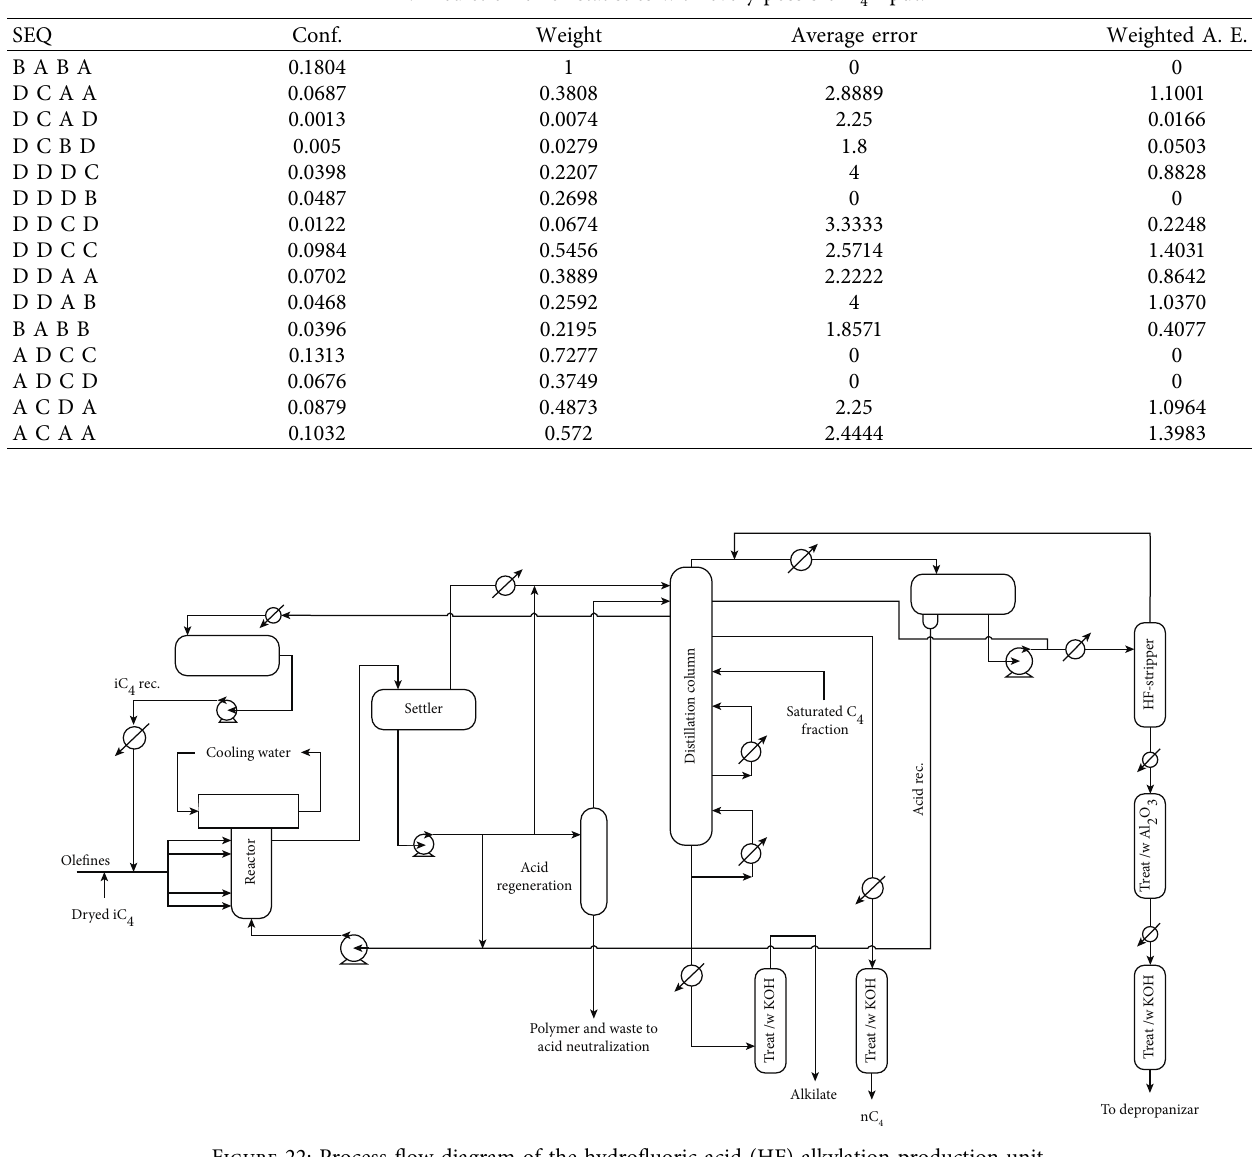
Table 3: Occurrence statistics of the frequent sequence starting events in D